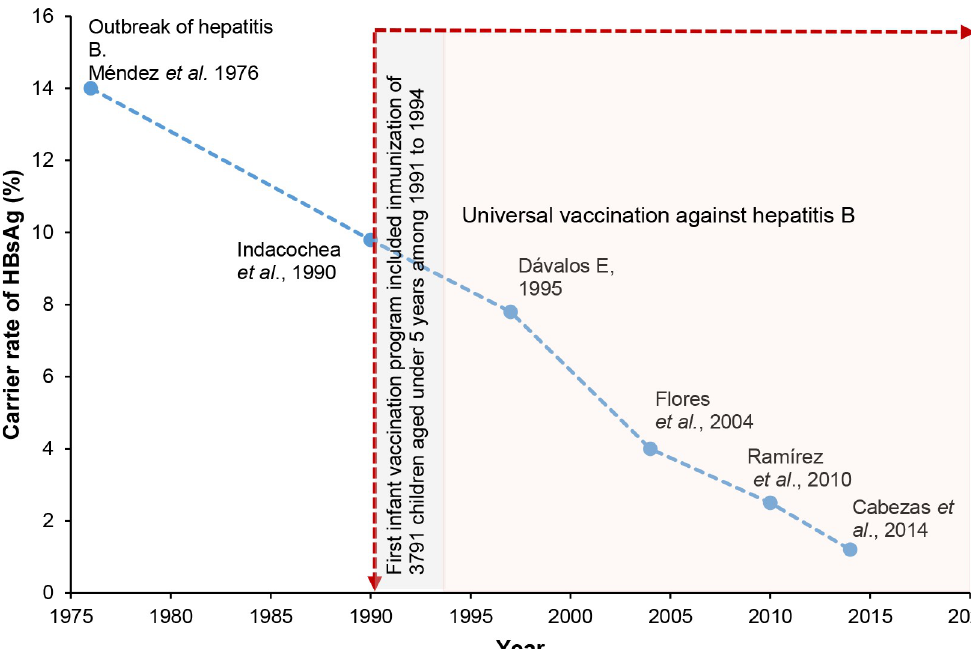
Fig 2. Carrier rates of HBsAg, compared with HBsAg carrier rates reported from previous studies, in Abancay province in Peru